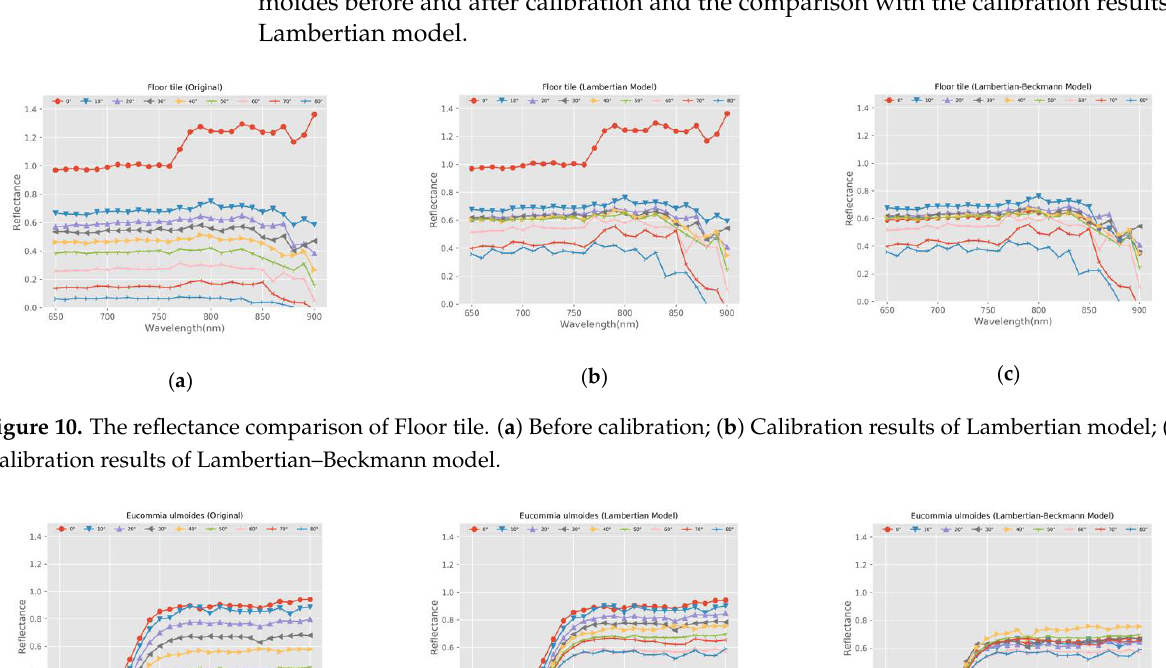
Figure 10. The reflectance comparison of Floor tile. ( a ) Before calibration; ( b ) Calibration results of Lambertian model; ( c ) Calibration results of Lambertian – Beckmann model .